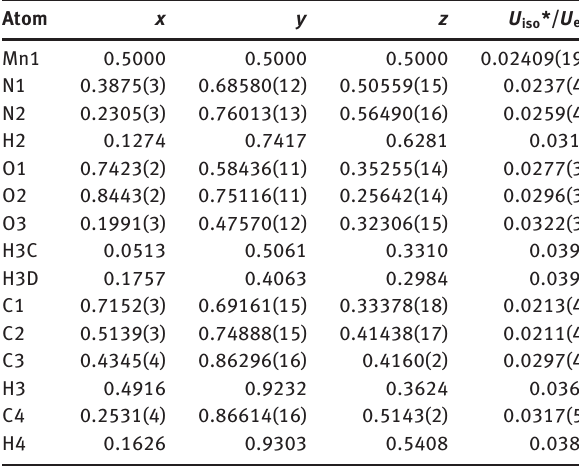
Table 2: Fractional atomic coordinates and isotropic or equivalent isotropic displacement parameters (Å 2